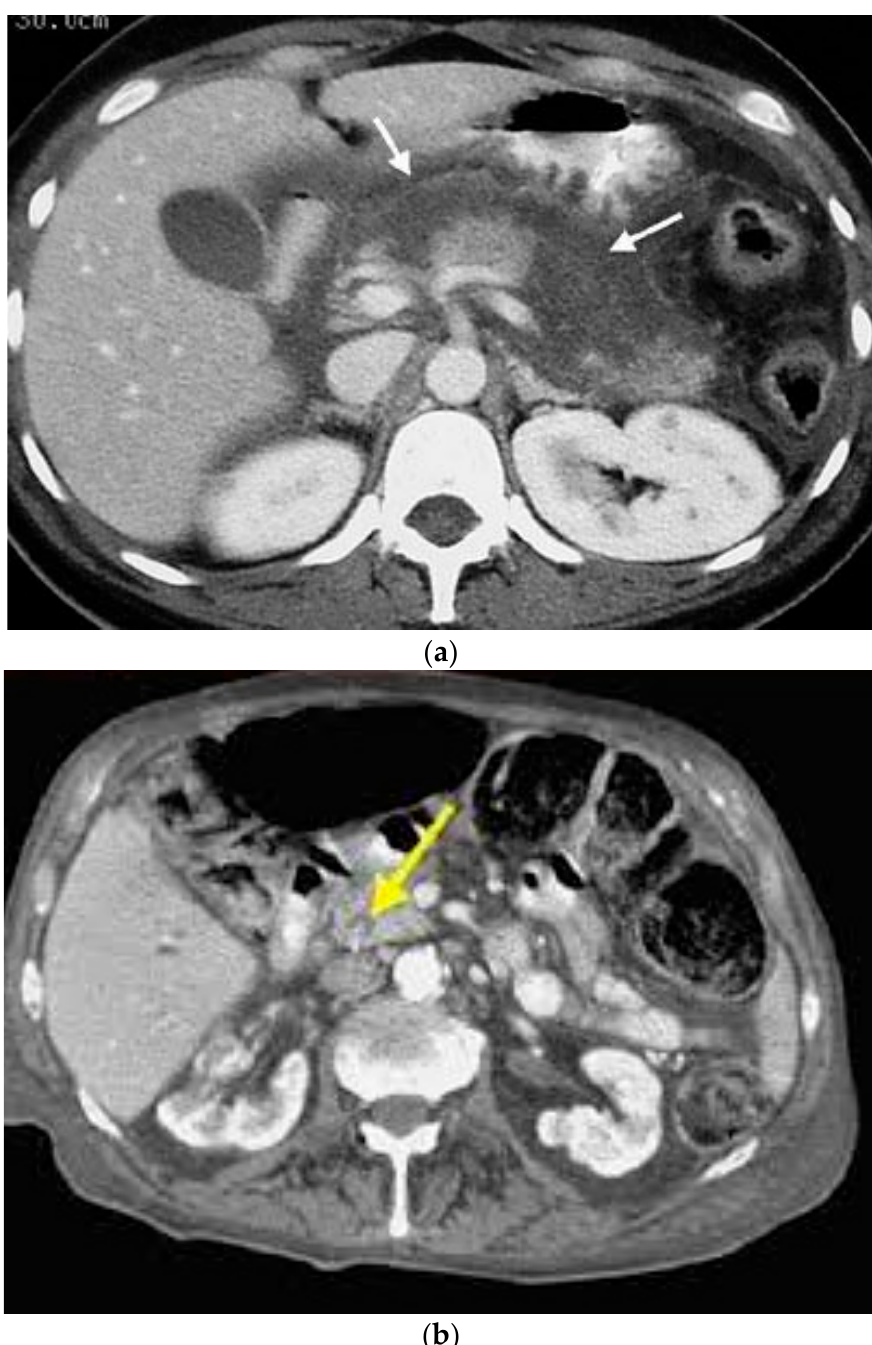
Figure 2. ( a , b ) describe acute edematous pancreatitis (arrow) associated with distended gallbladder and the presence of a 7 mm stone fragment in the ampulla of Vater.